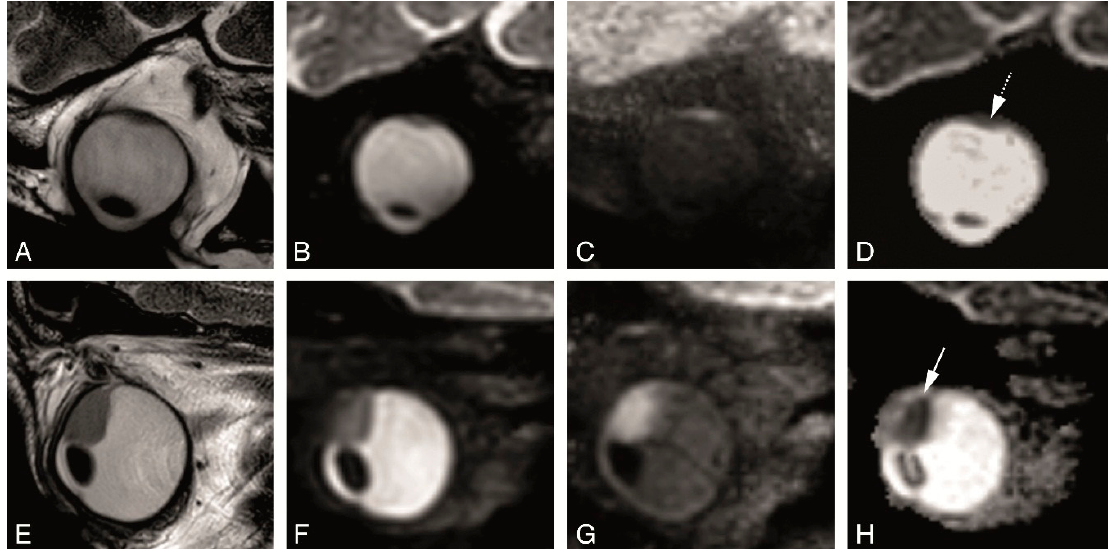
Figure 8. ( A – H ) TSE DWI in two different patients. ( A – D ) MS 2 mm sagittal oblique T2 ( A ), TSE DWI sagittal obliques with b values of 0 s/mm 2 ( B ), 800 s/mm 2 ( C ) and ADC ( D ). Restricted diffusion easy to appreciate in a small uveal melanoma (dashed arrow). ( E - H ) MS 2 mm sagittal oblique T2 ( E ), TSE DWI sagittal obliques with b values of 0 s/mm 2 ( F ), 800 s/mm 2 ( G ) and ADC ( H ). Clear restricted diffusion in the tumor (arrow).